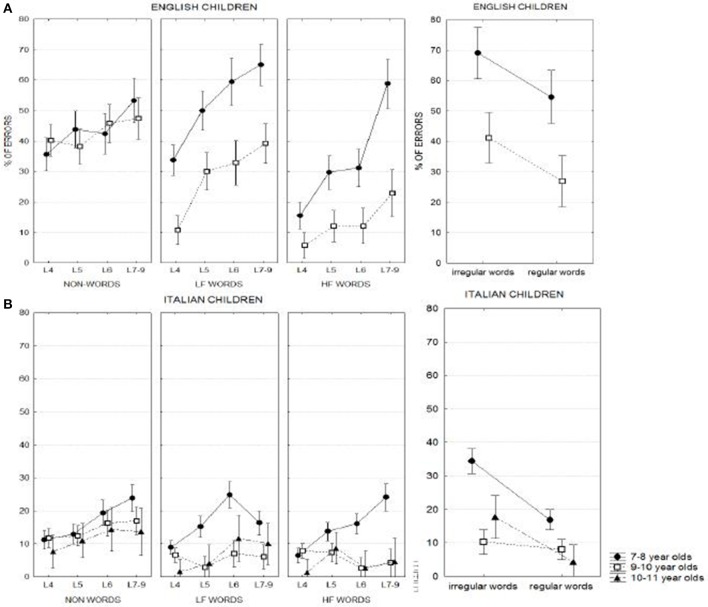
Mean percentage of errors in spelling different types of stimuli as a function of age in English (upper part) and Italian (bottom part) children. (A) Shows the children performance in spelling non-words, low frequency words and high frequency words; (B) represents the performance in spelling regular and irregular words. Lf, low frequency; hf, high frequency. L4, L5, L6, and L7–9 indicate respectively 4-, 5-, 6-, and 7–9- letters stimuli.